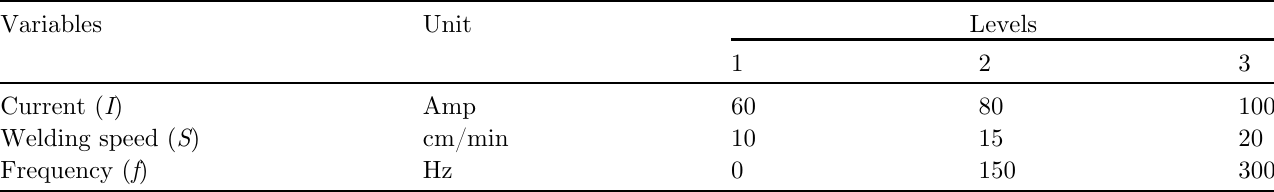
Table 3. Input parameters and levels.